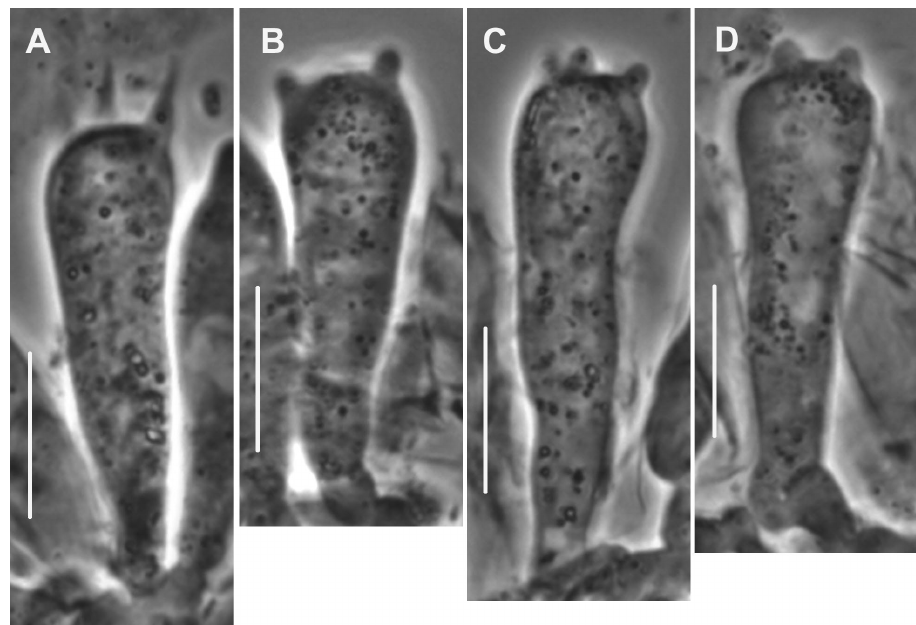
Figure 55. Mycetinis opacus . Basidia. Note multigranular contents. Standard bars = 10 µm. TFB 14629